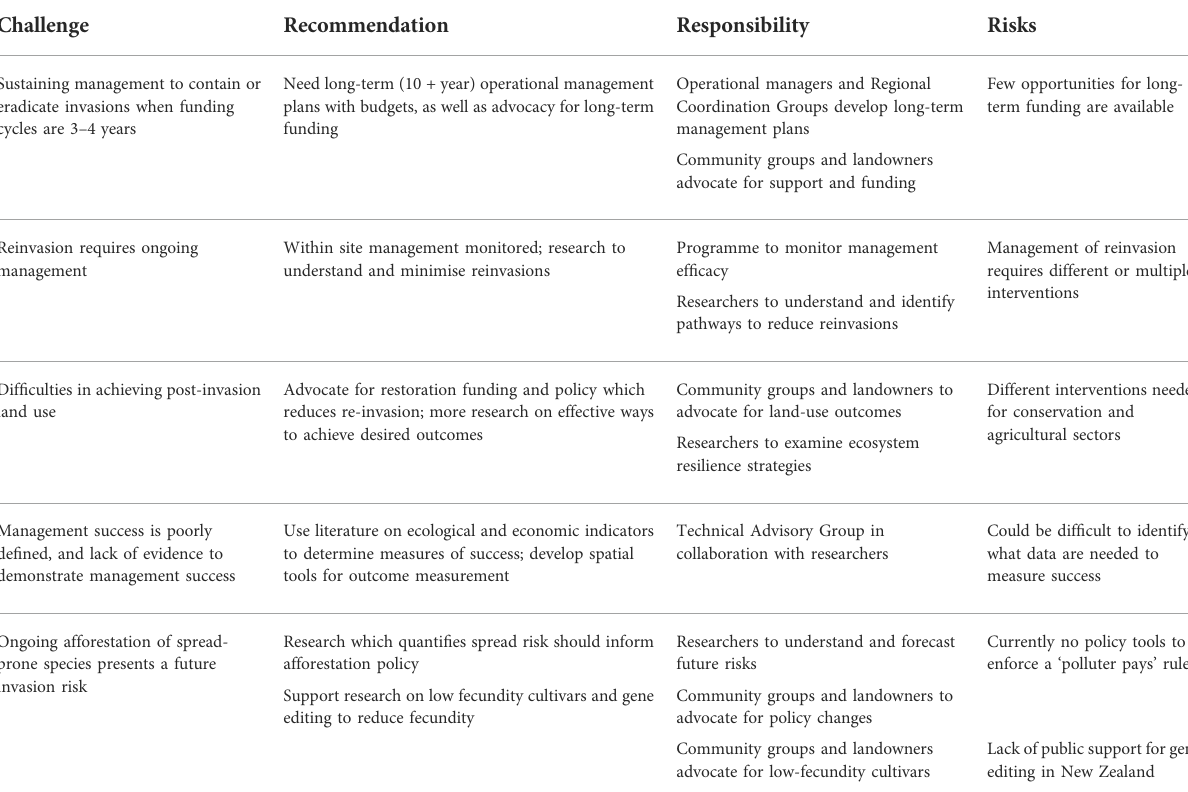
TABLE 2 Current challenges and recommendations in invasive conifer